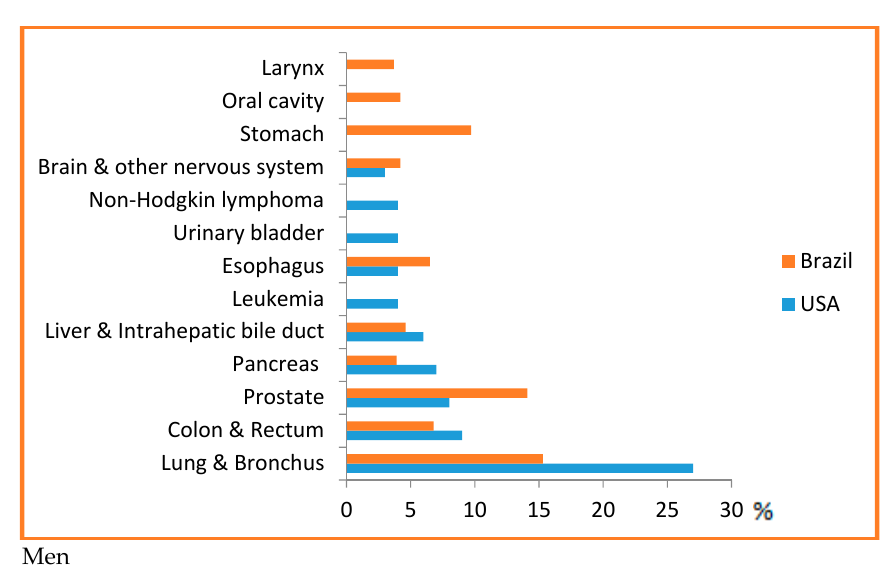
Women Figure 1. Top causes of cancer death, by sex in Brazil, 2008 [31] and the US [14]—Estimates for 2017. As estimates are rounded to more than ten cases, the exclusive cases of basal cells and squamous cells are skin cancers and carcinoma in situ, except for bladder urinary tract infection. Brazilian